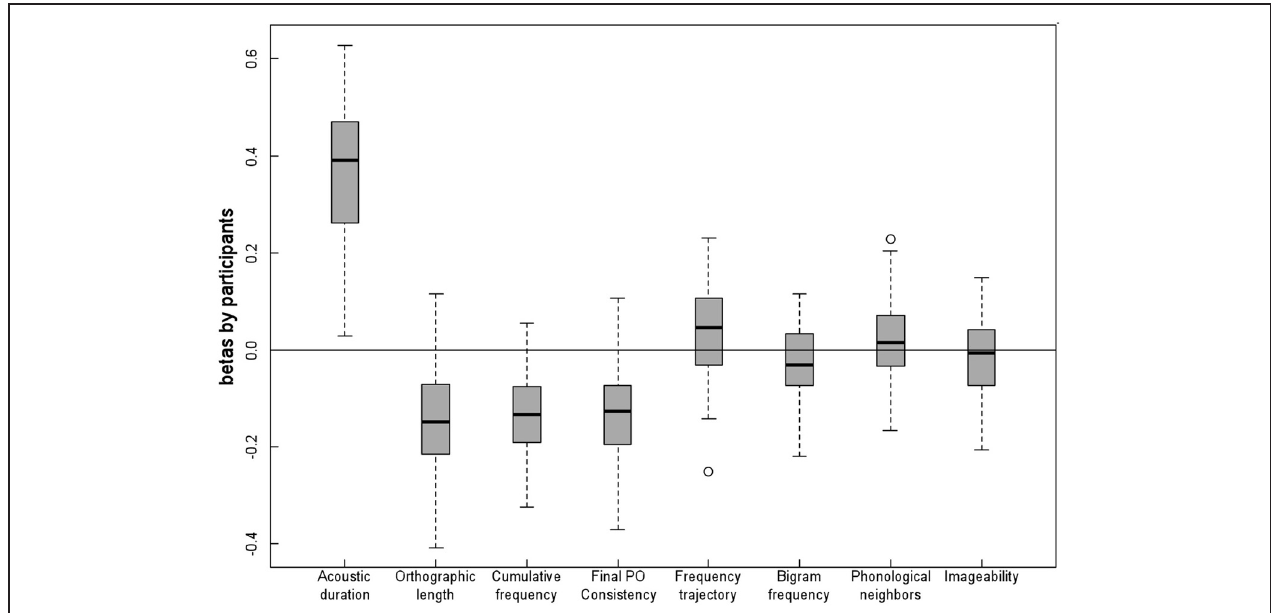
FIGURE 1 | Distributions of the by-participants’ standardized regression coefficients.